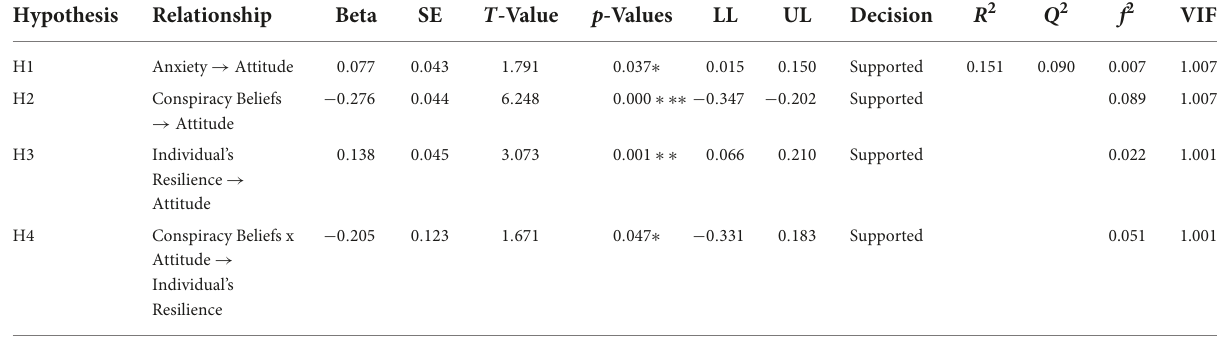
TABLE 7 Results of invariance measurement